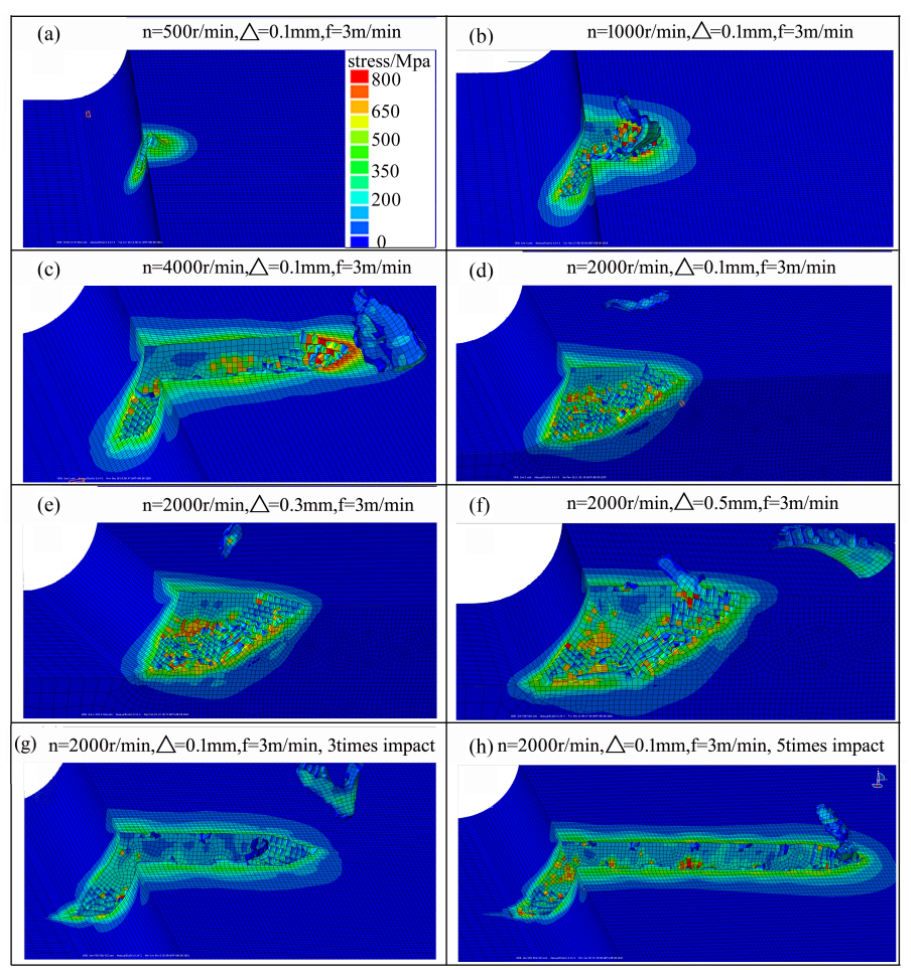
Figure 8. The material removal after the impact of SiC particle: ( a – c ) through increasing the revolu- tion speed; ( d – f ) through increasing the penetration depth; ( g , h ) through increasing the number of impact processes.